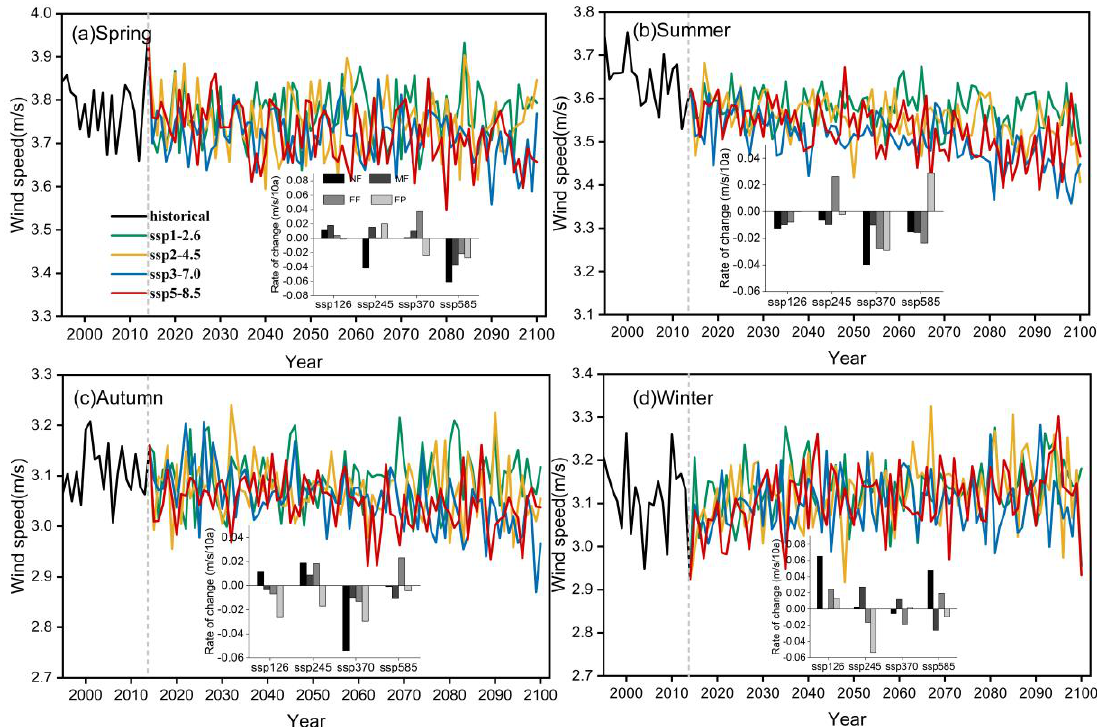
Figure 6. Variations in the seasonal wind speed in the ARNC from 1995 to 2100 under four emission scenarios. The black 6 bar chart shows the variation trend of surface wind speed in NF, MF, FF and